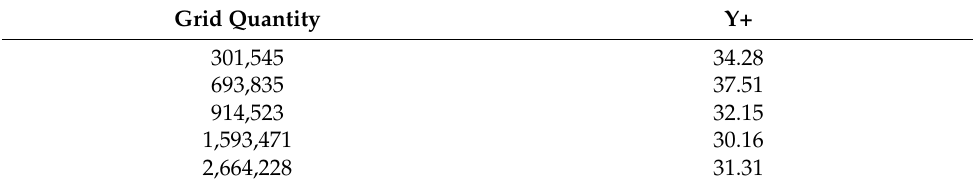
Figure 7. Volume mesh on Y = 0 clipping plane. Table 2. Reactor grid quantity and Y + value.